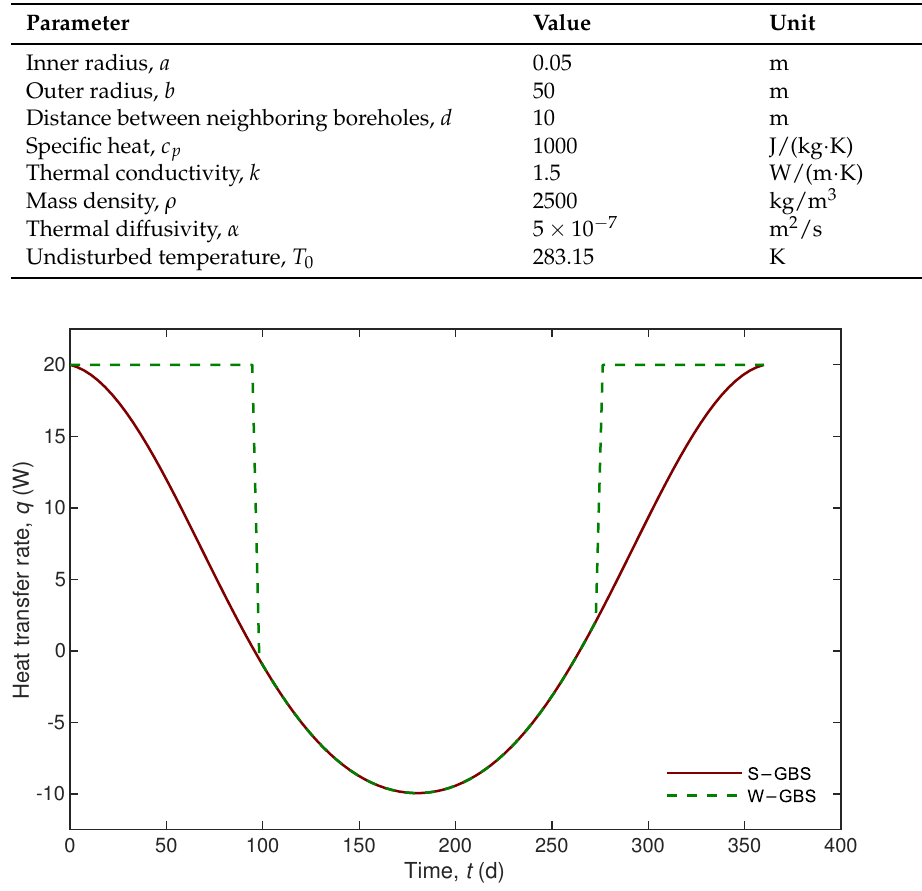
Figure 4. Heat transfer rate q (W) over a year period t (d) for seasonal energy storage in: solar-assisted geothermal borehole systems (S-GBS) and waste-heat-assisted geothermal borehole systems